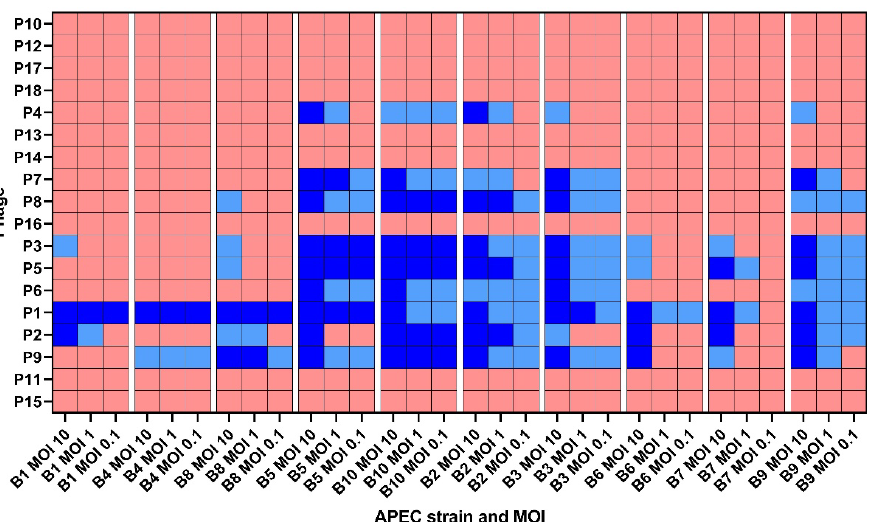
Figure 1. Infectivity of the tailed coliphages based on the endpoint optical density (OD). P = phage. B = bacterium. MOI = multiplicity of infection. Ratio = phage:APEC. OD was measured at 600 nm (OD600). Dark blue = final OD600: <0.2, light blue = final OD600: 0.2–0.5, and red = final OD600: >0.5. The final OD was determined based on the average of thirty-nine replicates. A total of 2869 phage–host combination experiments were performed. The average local virulence score and its standard error for each phage–bacterium combination are shown in Figure 2. All factors were significant, i.e., MOI (F 2,2495 = 938.8, p < 0.0001), phage (F 17,2495 = 1095.8, p < 0.0001), and bacterium (F 9,2495 = 459.5, p < 0.0001), and the interactions too but to a lesser extent, i.e., phage–bacterium (F 153,2495 = 42.8, p < 0.0001), phage–MOI (F 34,2495 = 10.7, p < 0.0001), and bacterium–MOI (F 18,2495 = 9.7, p < 0.0001). The phage effect was thus more pronounced than the bacterium effect. Based on the virulence scores, the greatest reduction in bacterial growth of the six strains B1, B2, B4, B6, B7, and B8 was observed with phage P1 and with phage P5 for the four strains B3, B5, B9, and B10.